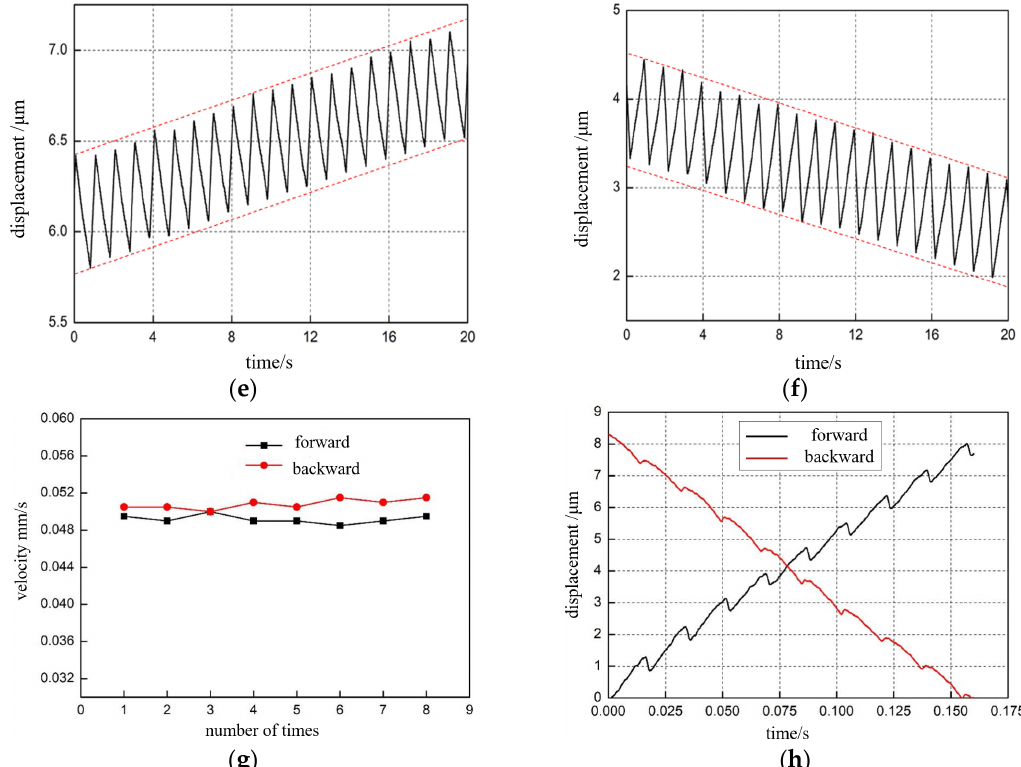
Figure 15. The results of the “macro-motion“ function test: ( a ) experimental results of the maximum step length of the macro-motion; ( b , c ) validation of simulation results of simulation methods; ( d ) positioning stage maximum thrust test experiment; ( e , f ) experimental results of the minimum step size of the macro-motion; and ( g , h ) consistency experiment of forward and backward motion of positioning stage.